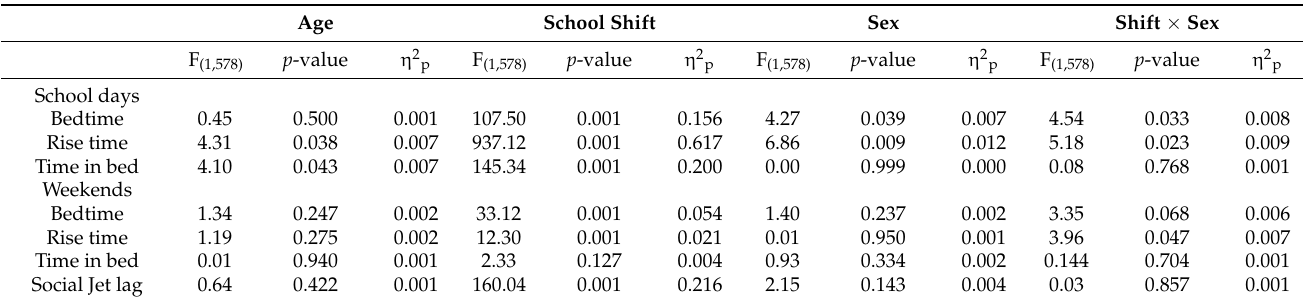
Table 2. Statistical data (Fs, p -value, and partial eta square) on each sleep variable and social jet lag according to school shift and sex (age as a